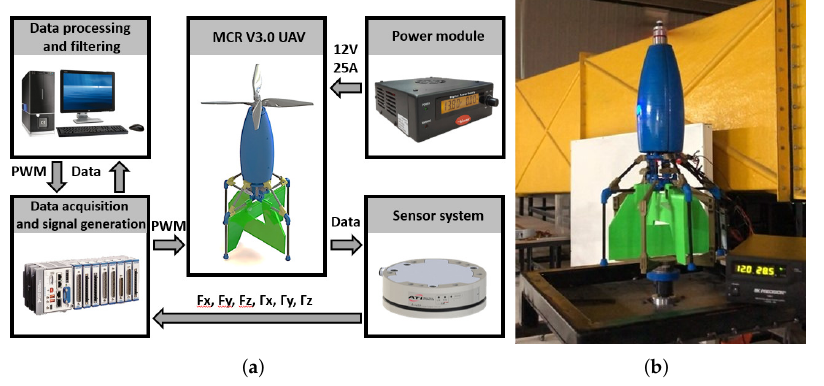
Figure 23. MCR UAV v3.0 aerodynamical characterization procedure. ( a ) Block diagram of the experimental test bench. ( b ) Experimental platform used to measure forces and